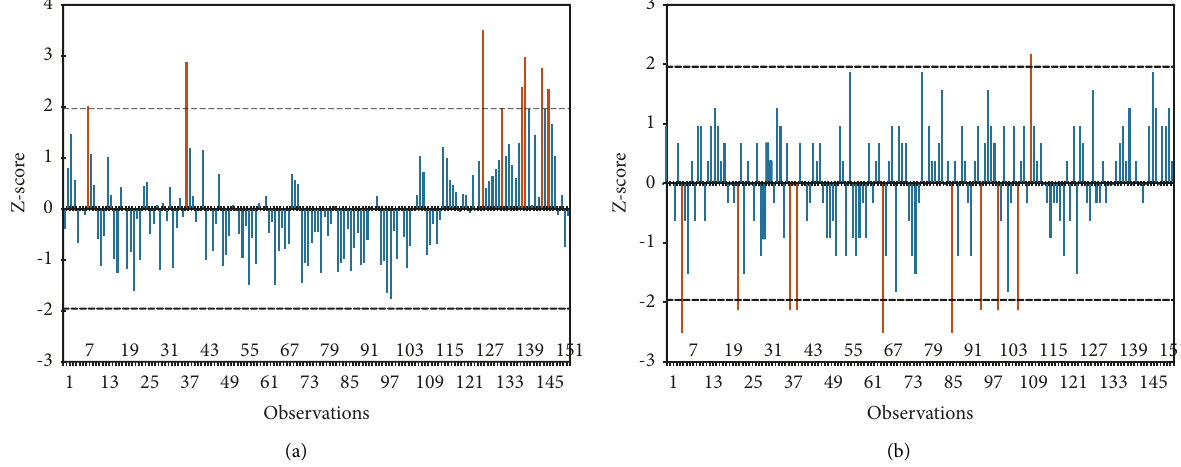
Figure 4: Z-standardization test performed on observed data for parameters: (a) amplitude and (b)